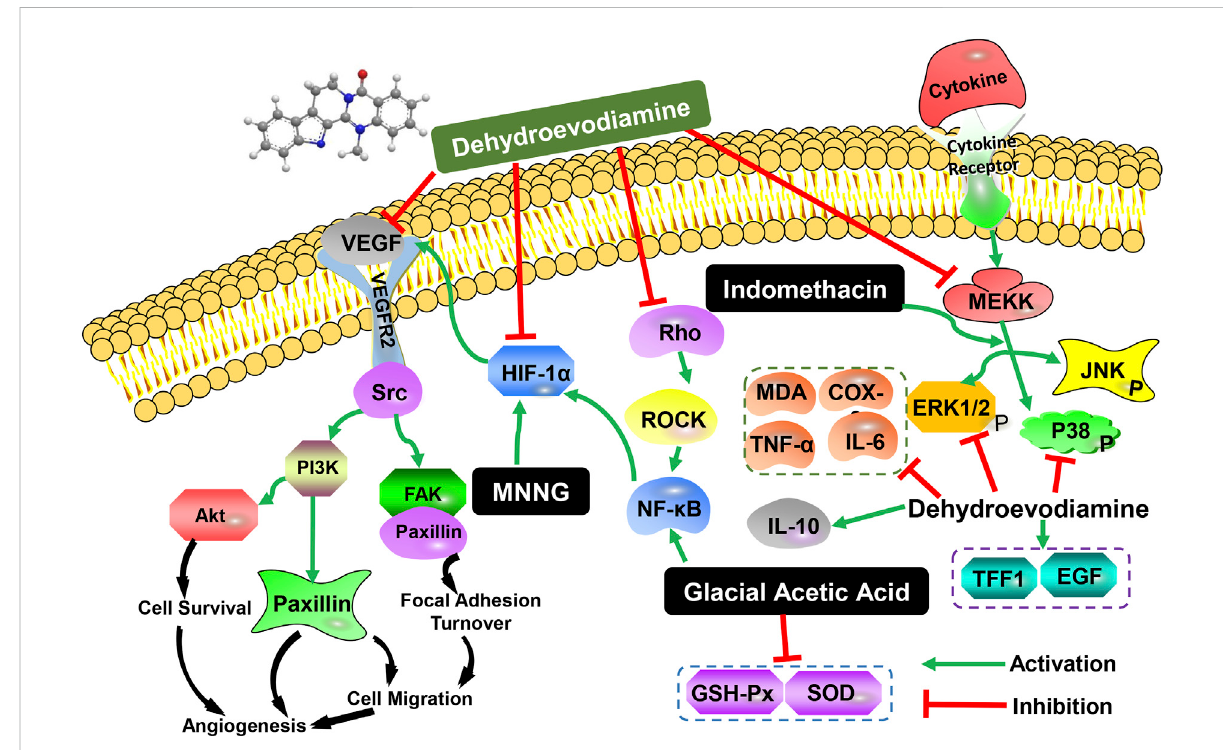
FIGURE 2 The main biological activities and possible molecular mechanisms of DHE on the digestive